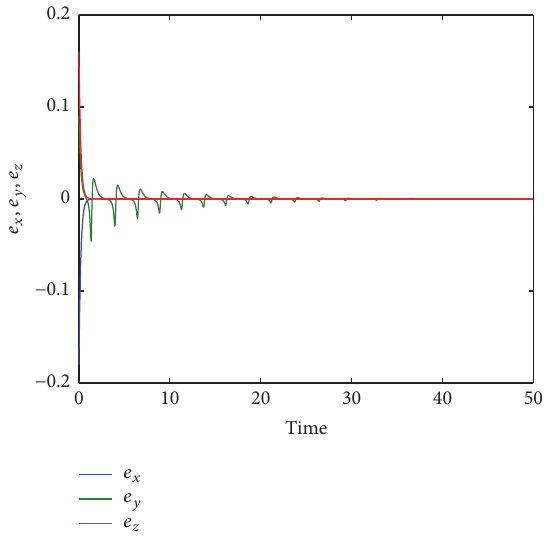
Figure 10: Time-history of the antisynchronization errors between the systems with cloud-shaped equilibrium (13) and